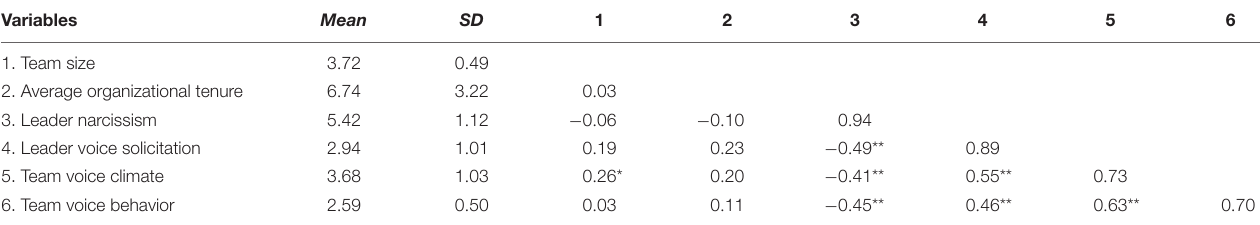
TABLE 1 | Means, standard deviations, correlations, and reliabilities. Variables